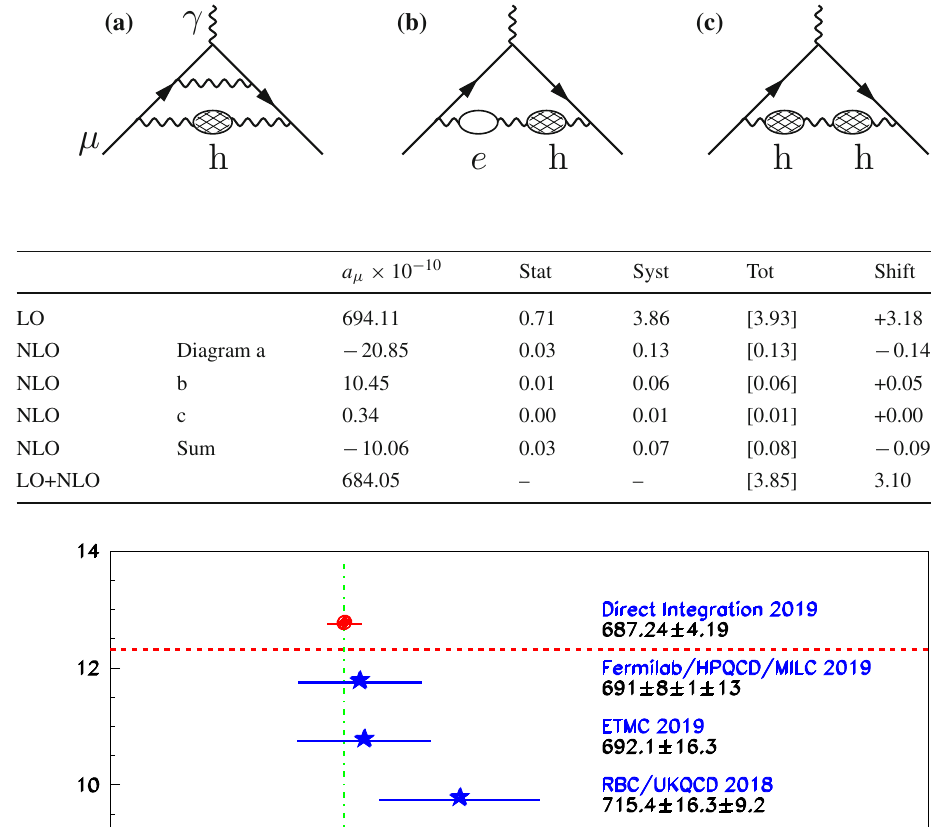
Fig. 13 Recent evaluations